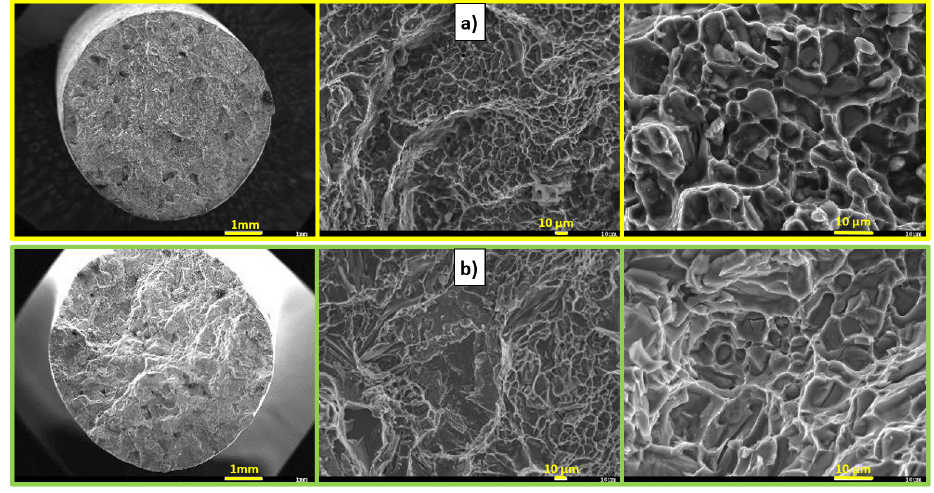
Figure 5. Macroscopic and microscopic character of fracture surfaces after heat treatment, SEM; ( a ) R alloy, ( b ) P alloy.